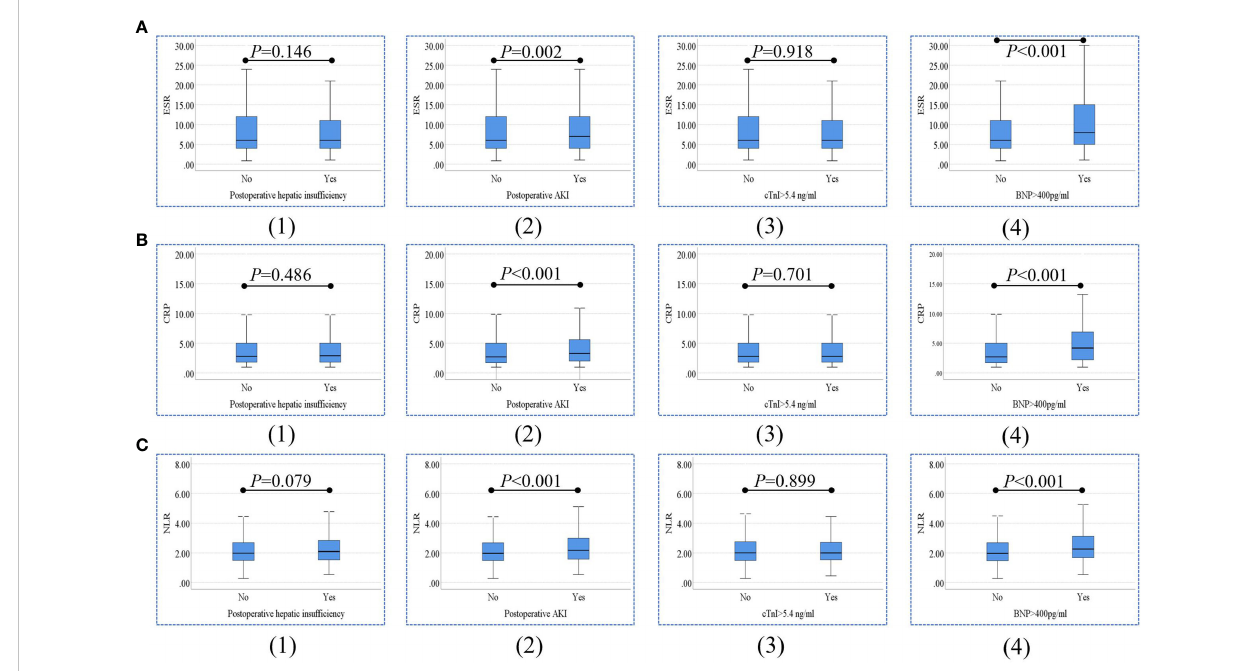
FIGURE 2 Comparisons of ESR (A) , CRP levels (B) , and NLR (C) between patients with and without postoperative hepatic insuf fi ciency (1), AKI (2), cTnI level >5.4 ng/ml (3), and BNP level >400 pg/ml (4). ESR, erythrocyte sedimentation rate; CRP, C-reactive protein; NLR, neutrophil-to-lymphocyte ratio; BNP,